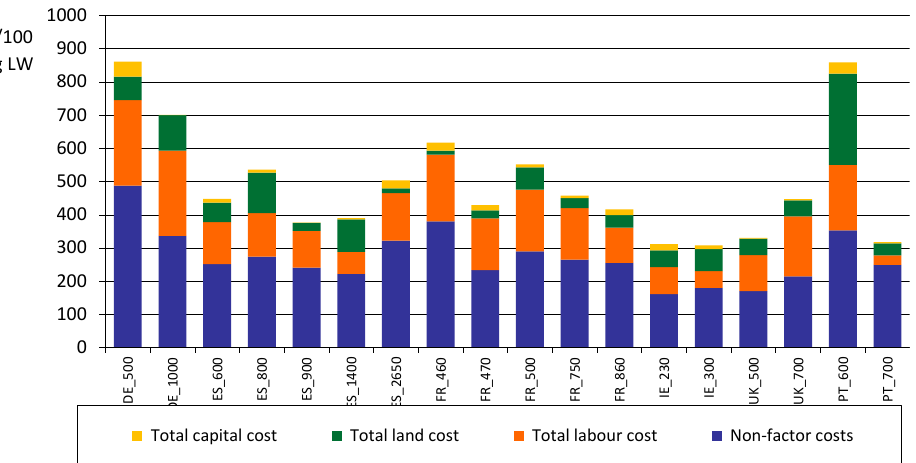
Figure 8. Cost by factor and non-factor costs (€/100 kg LW). Source: model results.